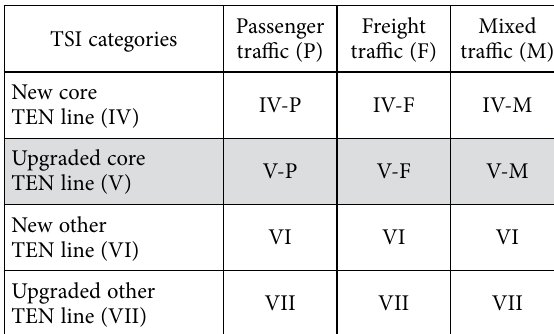
Table 2. TSI categories of railway lines (EC 2011a)